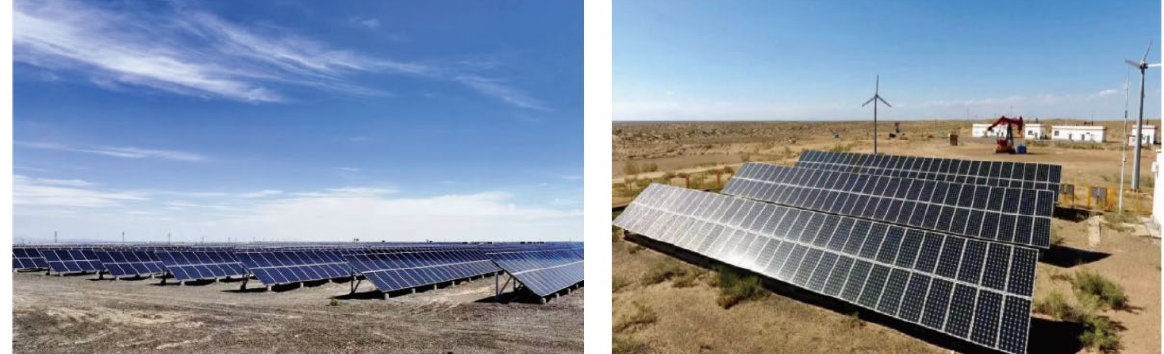
Figure 7. ( left ) One of the solar power plants in Karamay city. ( right ) Solar and wind power facilities in Fengcheng oilfield, Karamay city. (Photographed by one of the authors).